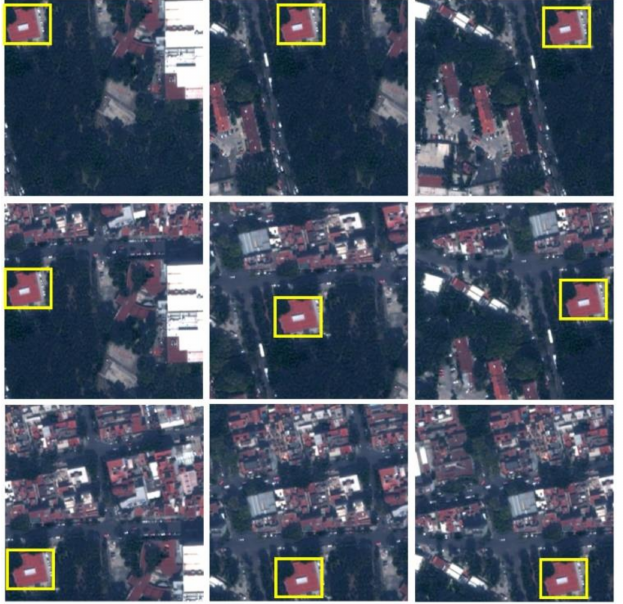
Figure 3. An example of data augmentation (shifting): an intact building label is fed to the network in nine different